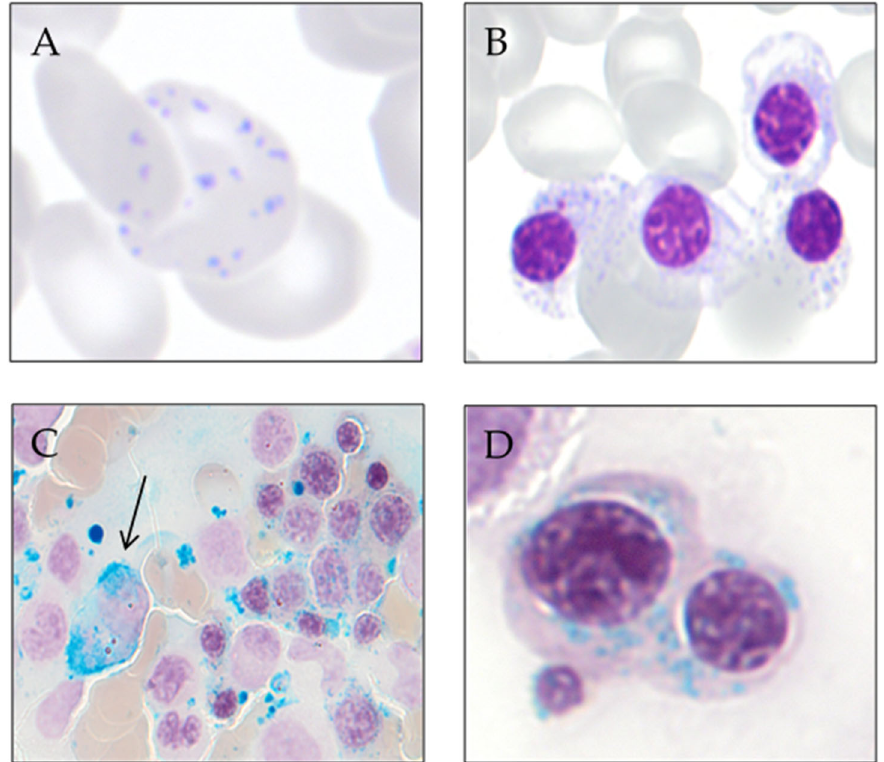
Figure 2. Smears from a patient with MDS with ring sideroblasts. ( A ) Peripheral blood red cell with coexistence of anomalous distribution of hemoglobin and basophilic stippling (May ‐ Grünwald Giemsa). ( B ) Bone marrow erythroblast with poorly hemoglobinized cytoplasm and basophilic stippling (May ‐ Grünwald Giemsa). ( C ) Bone marrow smear at low magnification showing an iron ‐ laden macrophage (arrow) and numerous ring sideroblasts (Perls’ reaction). ( D ) Bone marrow ring sideroblasts (Perls’ reaction).